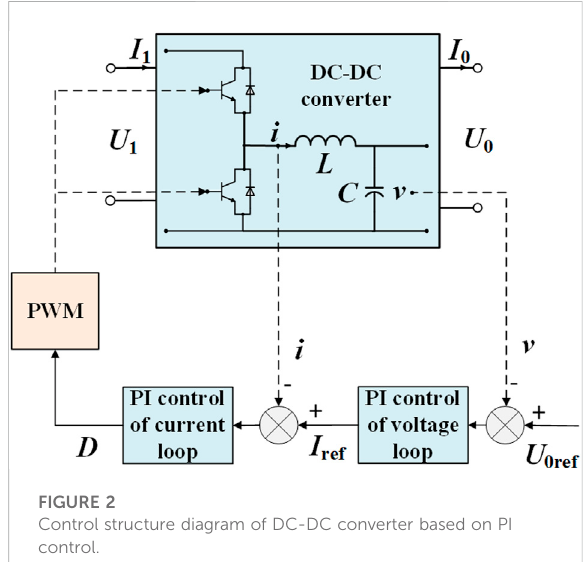
FIGURE 2 Control structure diagram of DC-DC converter based on PI